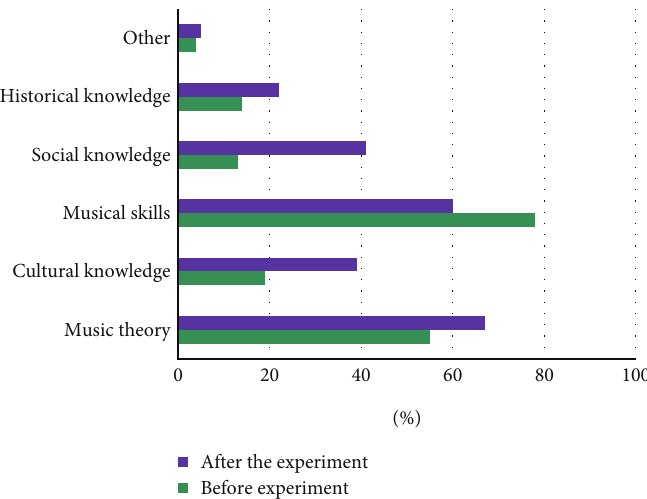
Figure 4: Proportion of options for students to choose “ what knowledge should be learned in music study class ”